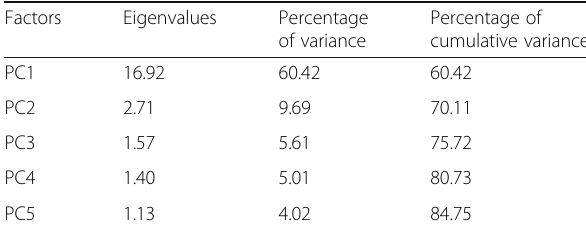
Table 5 Eigenvalues, percentage of variance, and percentage of cumulative variance for the five factors of A. clupeoides for truss morphometric measurements Factors